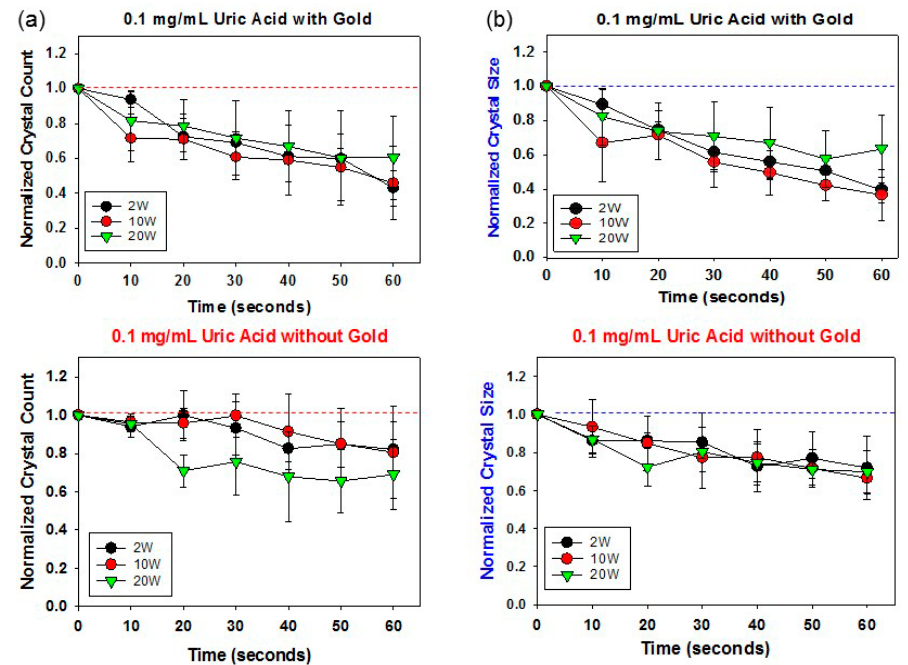
Figure 1. Normalized crystal ( a ) count and ( b ) size retention rate of uric acid crystals in the presence of gold nanoparticles during 60 s of microwave heating. The initial concentration of uric acid crystals was set to 0.1 mg/mL.